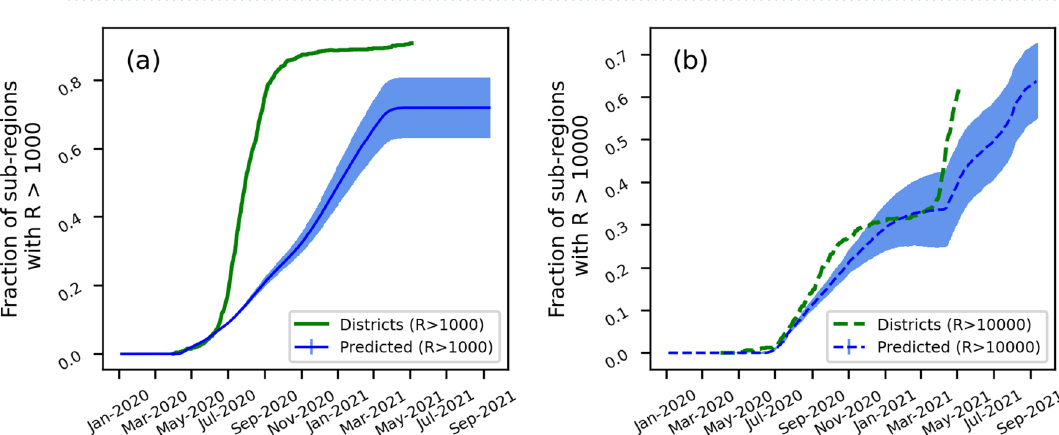
Figure 3. Comparing the predictions for the sub-regions in our model with the actual data from Indian districts. The y-axis represents the fraction of sub-regions (blue line)/districts (green line) with ( a ) more than 1000 recovered cases and ( b ) more than 10,000 recovered cases. The shaded regions represent the standard error from 10